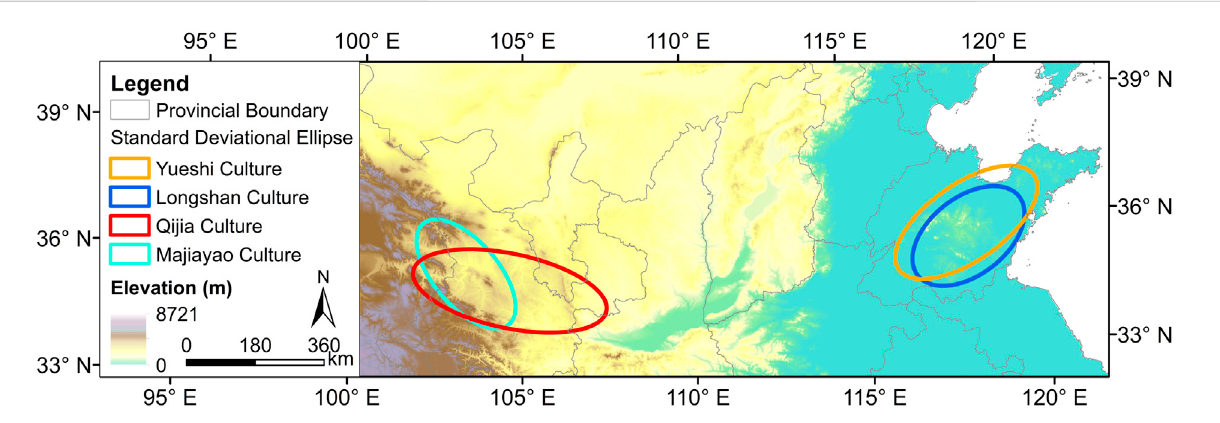
FIGURE 4 Comparison of standard deviational ellipses (SDEs) for the successive ended and started cultures. Note: the Majiayao culture (cyan) vs. the Qijia culture (red); the Longshan culture (blue) vs. the Yueshi culture (orange).